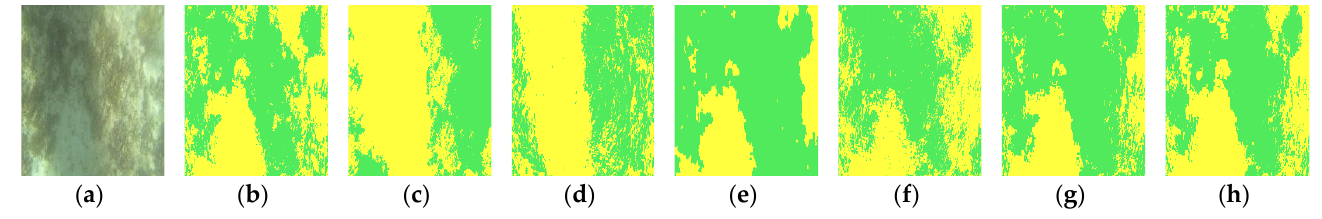
Figure 6. Validation tests of the proposed segmentation algorithms using highly illuminated and low contrast algae image (11) from Figure 3 as example of three categories: ( a ) original image; ( b ) ground truth image; ( c ) FF result; ( d ) FR result; ( e ) OS result; ( f ) KM result. Green: algae, brown: brown algae, and yellow: sediments.